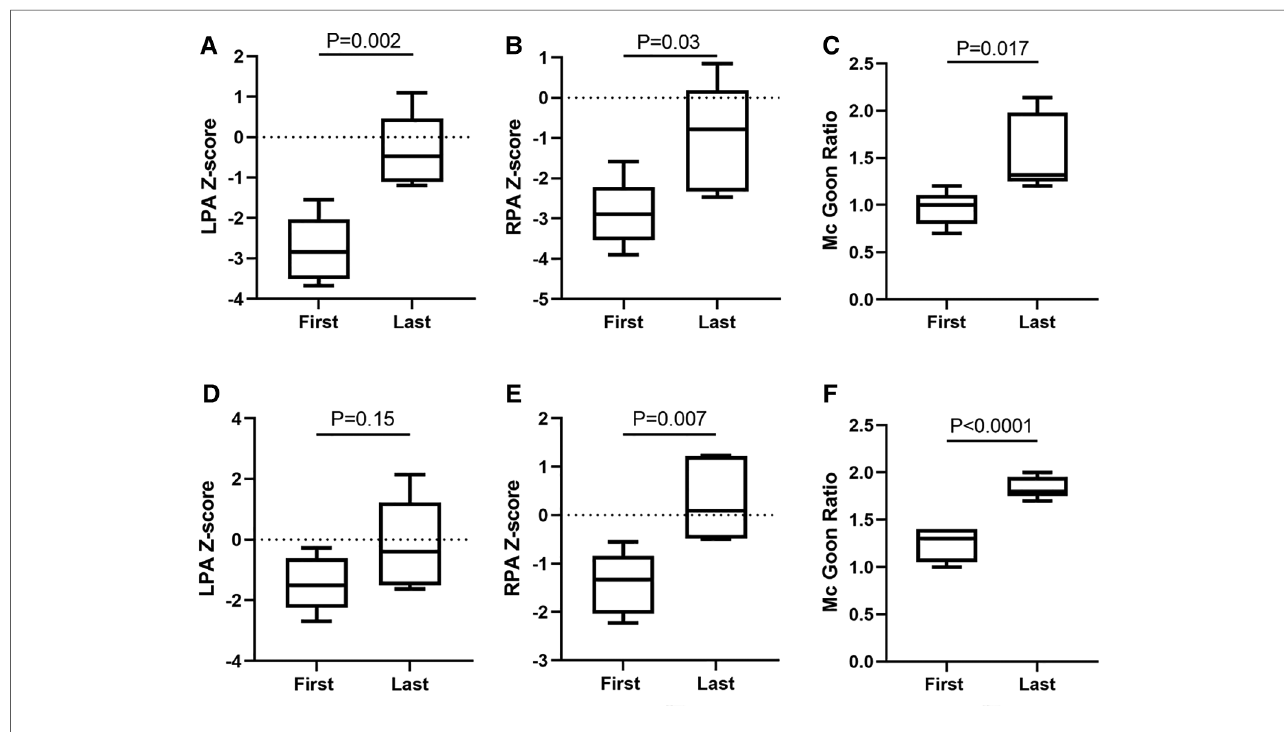
FIGURE 1 Pulmonary artery growth. Box is fi rst to third quartile. Median is line in box. First, Cardiovascular CTA measure diameter before palliation procedure. Last, Cardiovascular CTA measure diameter before fi nal surgical repair. ROVTs group showed in ( A – C ); mBTS group showed in ( D – F ).